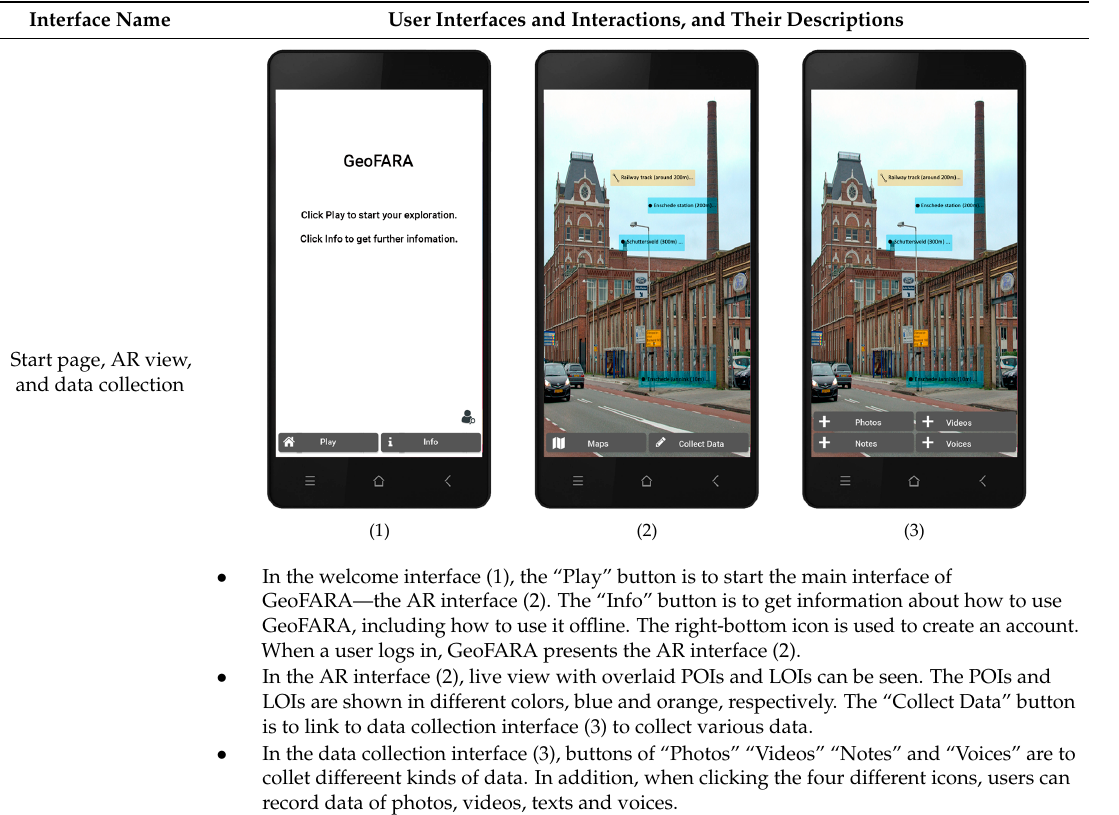
Table 4. User interfaces and interactions of GeoFARA and descriptions.